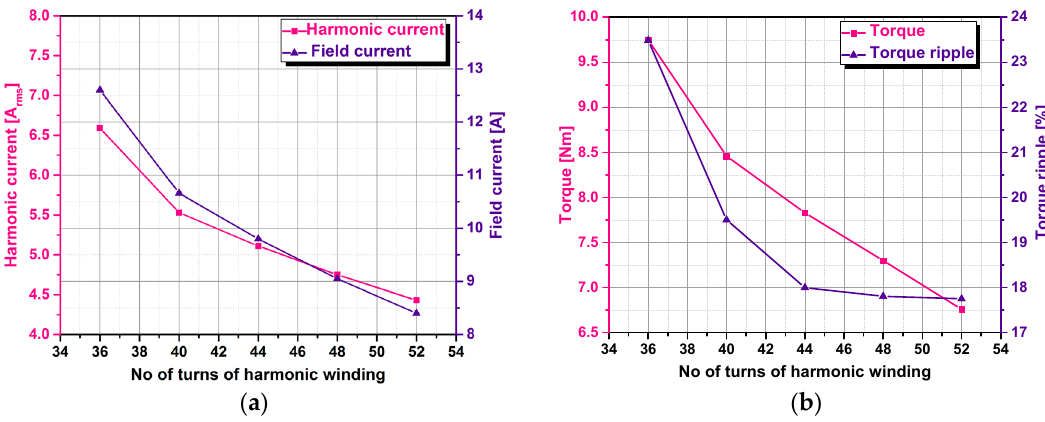
Figure 14. Effect of variation in harmonic winding turns on: ( a ) harmonic and field current; ( b ) torque and torque ripple. Table 2. Performance comparison by 2 ‐ D finite element analysis.